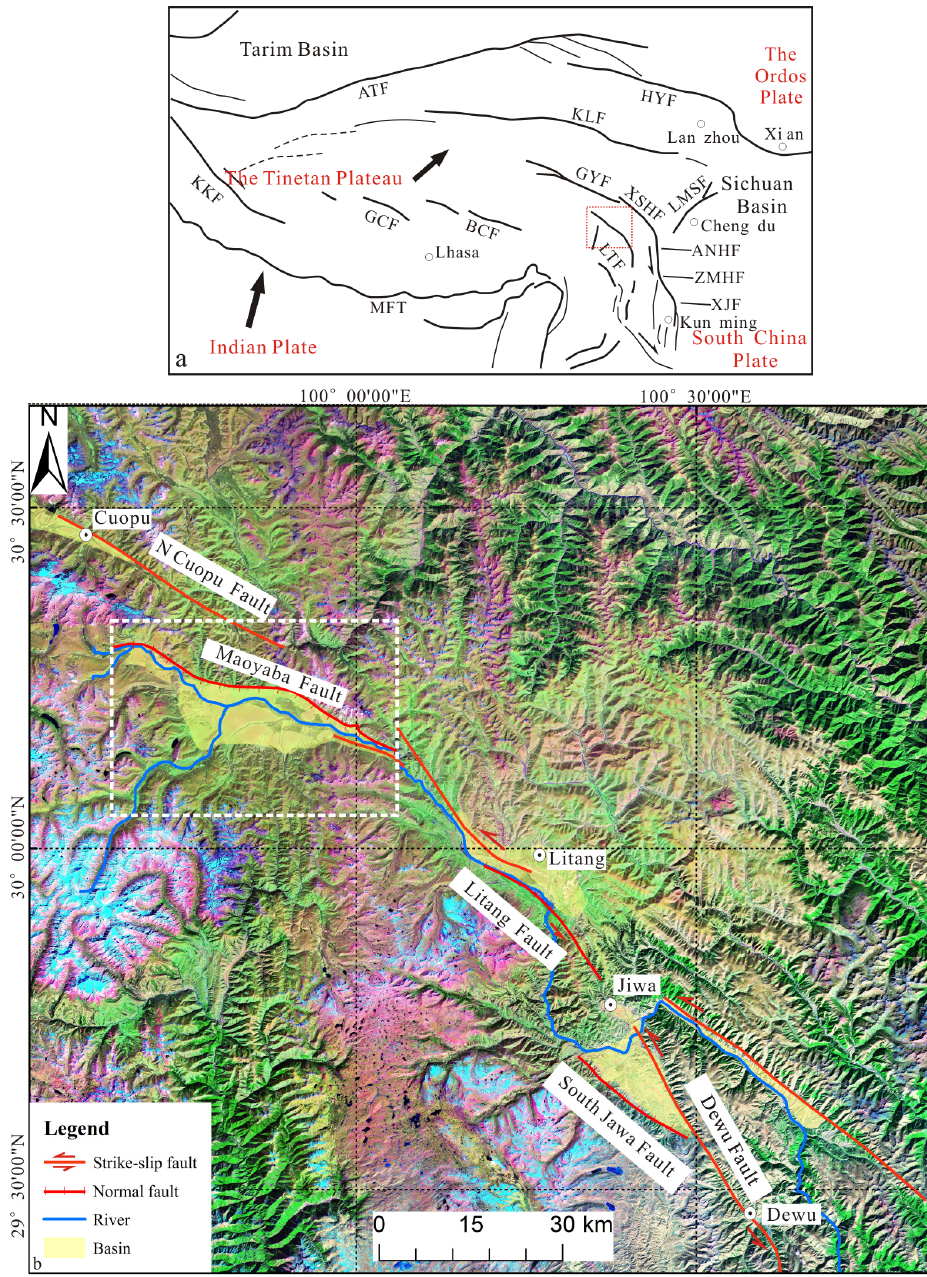
Figure 1. Geometric distribution of the Litang fault. ( a ) Index maps of the west of China. The black arrows indicate the motion of the India plate relative to the Eurasian plane. The red rectangular box shows the Litang fault in Figure 1b. The black lines show the main active faults in the Tibetan plateau and the adjacent areas: LTF: Litang Fault; ATF: Altyn Tagh Fault; HYF: Haiyuan Fault; KLF: Kunlunshan Fault; GYF: Ganzi-Yushu Fault; XSHF: Xianshuihe Fault; ANHF: Anninghe Fault; ZMHF: Zemuhe Fault; XJF: Xiaojiang Fault; LMSF: Longmen Shan Fault; KKF: Karakoram Fault; GCF: Gyaring Co fault; BCF: Beng Co Fault; MFT: Main Frontal Thrust. ( b ) The Litang fault on the Landsat 7 satellite image. The Litang fault is a sinistral-lateral strike slip fault and it is composed of the Cuopu fault, the Maoyaba fault, the Litang fault and the Jiawa-Dewu fault. The white rectangular box represents the geometric distribution of the Maoyaba fault in Figure 2.